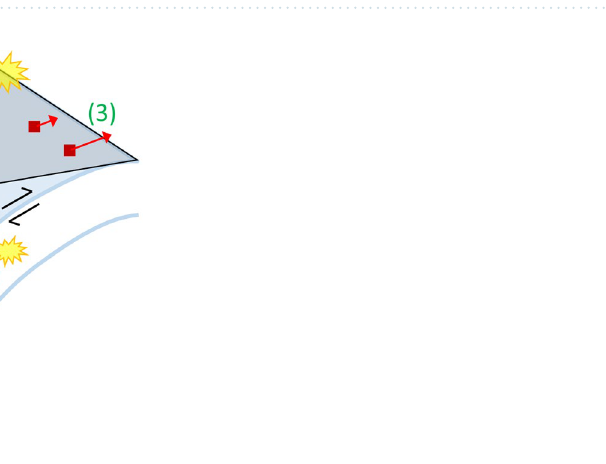
Figure 6. Comparison between the GNSS observation and the simulation results of the viscoelastic model in the previous study 10 during period P3, at the TONG station (left) and the NIUM station (right). Figures generated with R 3.x (https ://www.r-proje ct.org/).